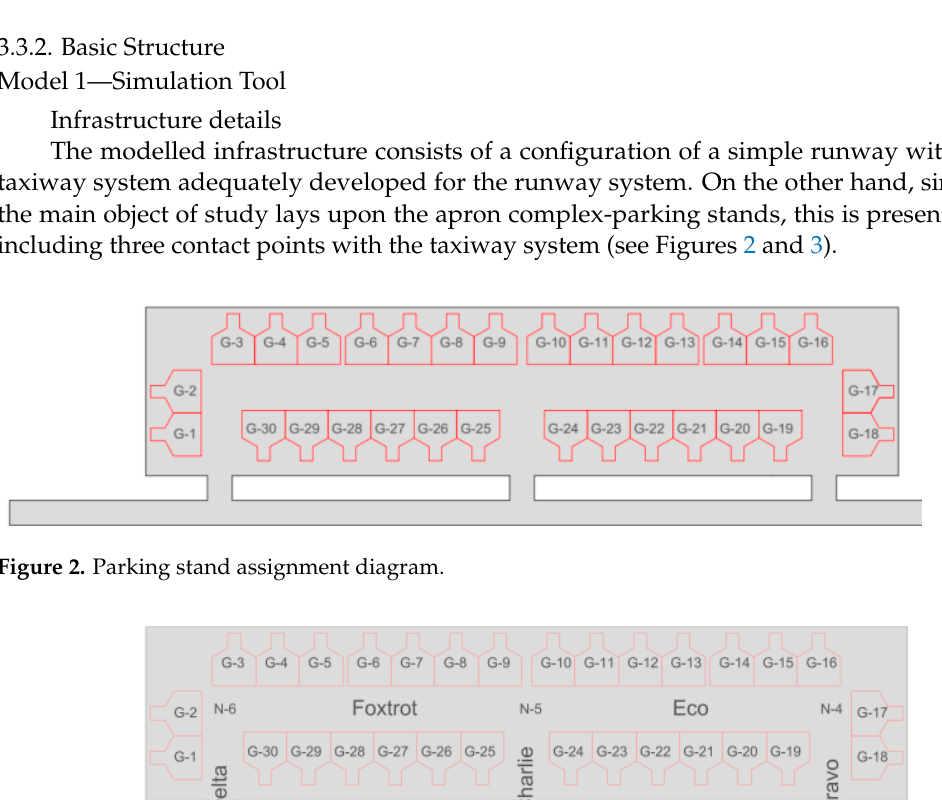
Figure 3. Taxiway